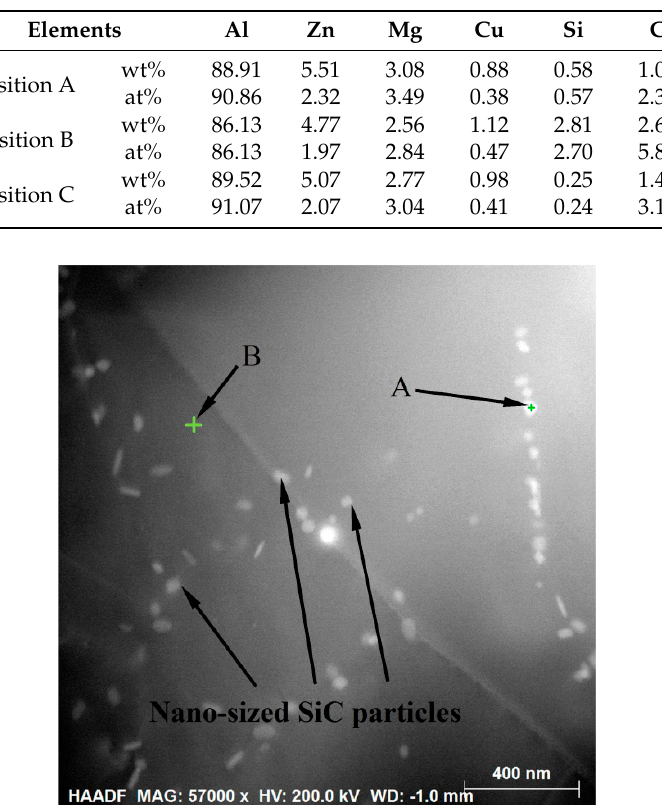
Figure 12. High-resolution TEM micrograph of the thixoformed part soaked for 10 min at 590 °C. Table 2. Element in location A of the thixoformed part soaked for 10 min at 590 °C.